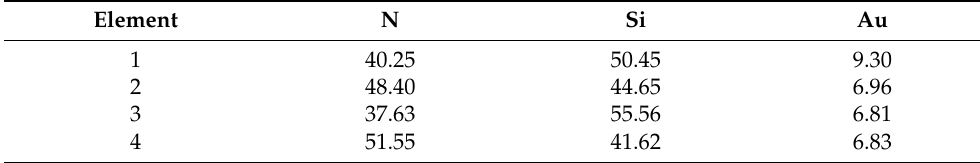
Table 1. Microarea percent ratio of points 1, 2, 3, and 4 in Figure 4/Atomic%.